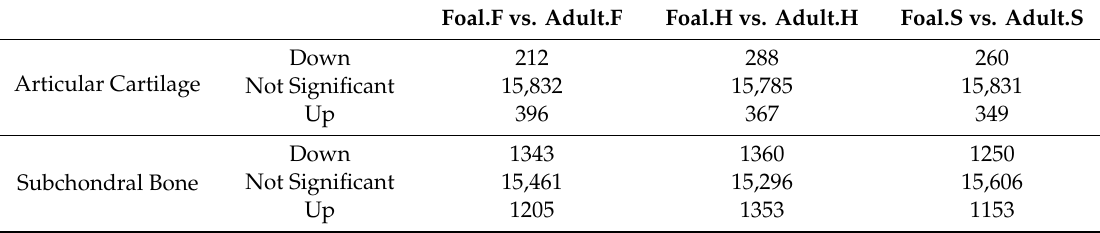
Table 1. Number of DE genes with FC > | 1.5 | and global FDR p < 0.05 in articular cartilage and subchondral bone. DE is calculated by joint location. F = fetlock (metatarsophalangeal joint); H = hock (tarsocrural joint); S = stifle (femoropatellar joint). Foal.F vs Adult.F Foal.H vs Adult.H